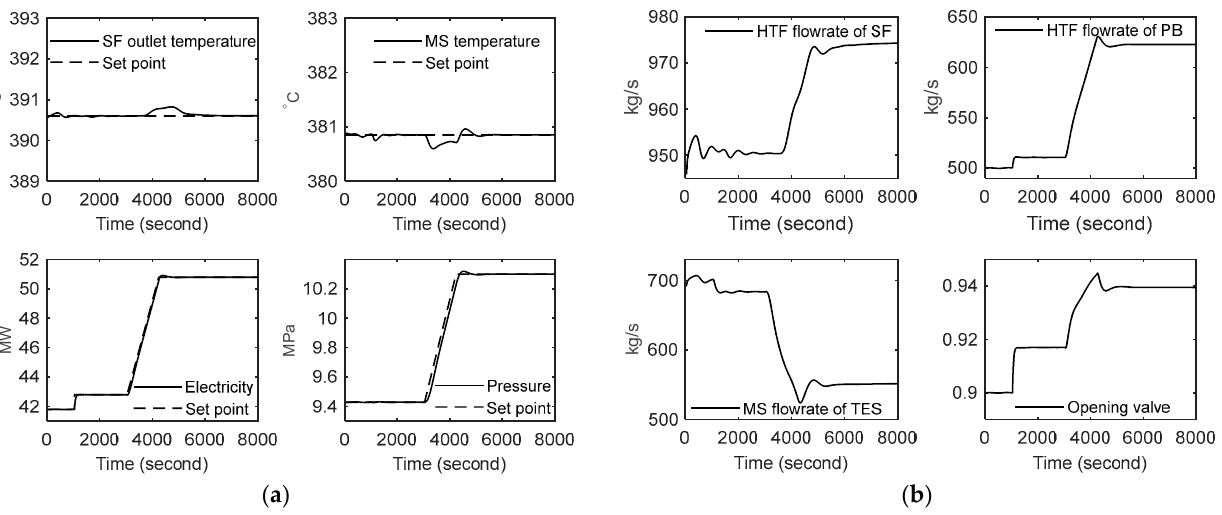
Figure 11. Simulation of wide-range load variation tracking: ( a ) the controlled variables; ( b ) the manipulated variables.